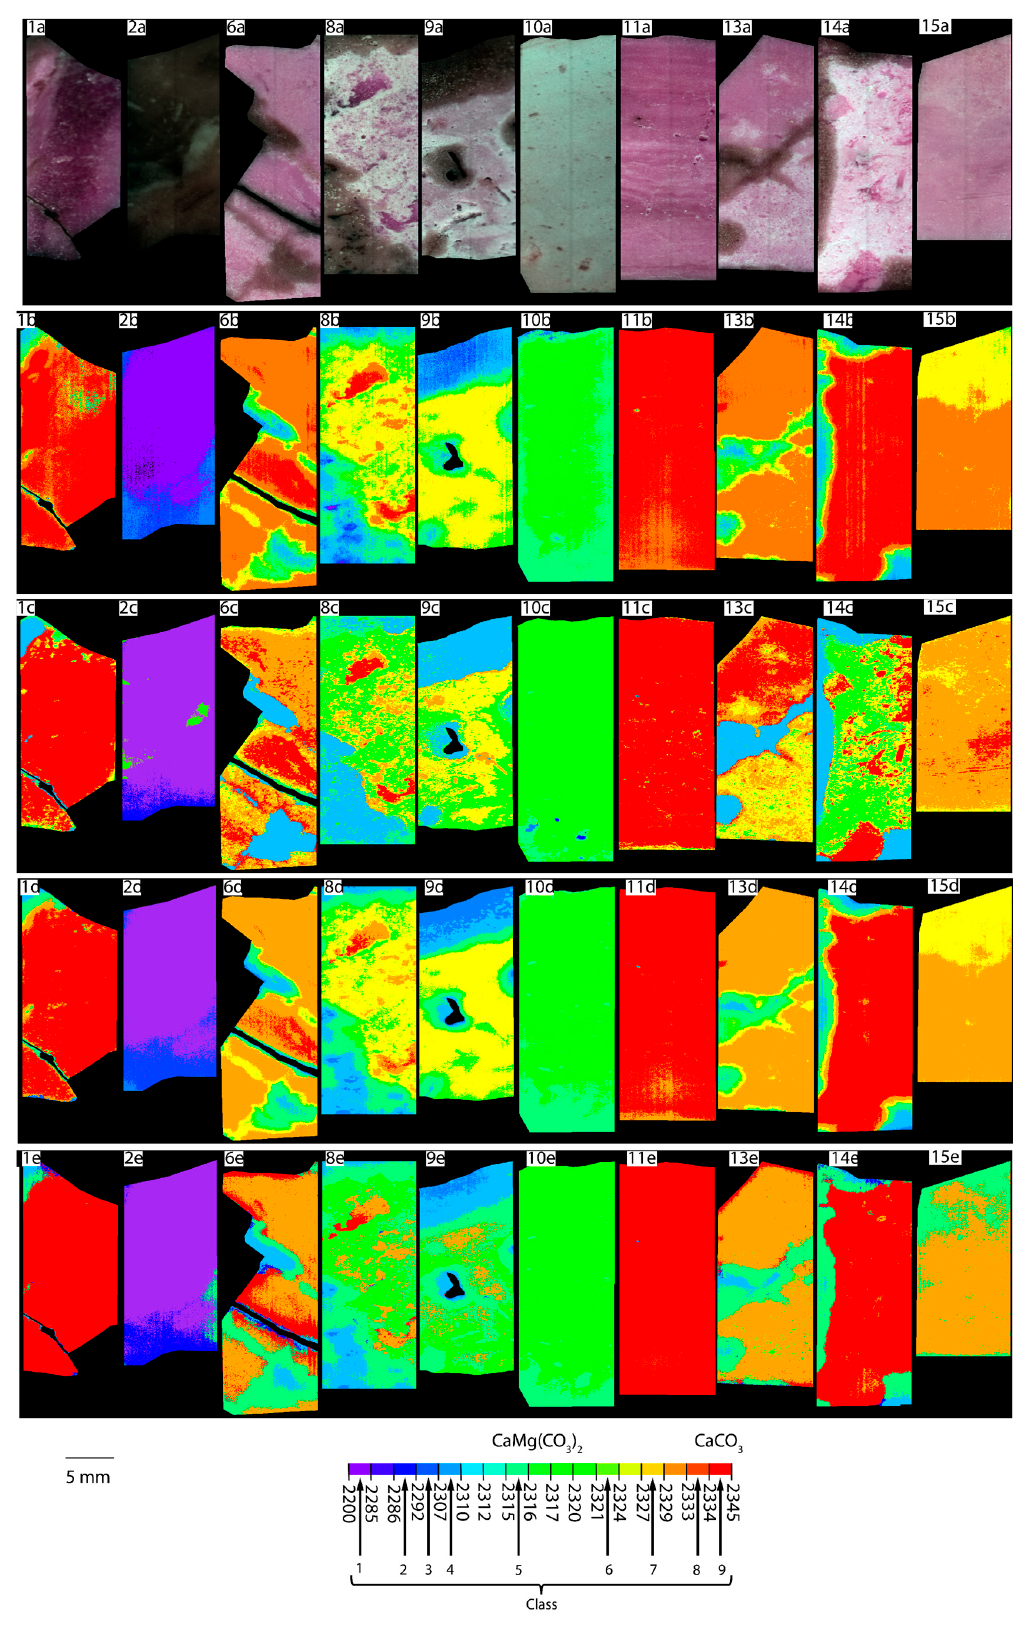
Figure 8. Rock chips from the Lake Georgetown spillway: ( 1–15a ) in 2102, 2334, and 2397 nm RGB false color composites and ( 1–15b ) with minimum wavelength positions mapped. ( 1–15c ) spectral angle mapper, ( 1–15d ) support vector machine, and ( 1–15e ) Neural Network classifications.